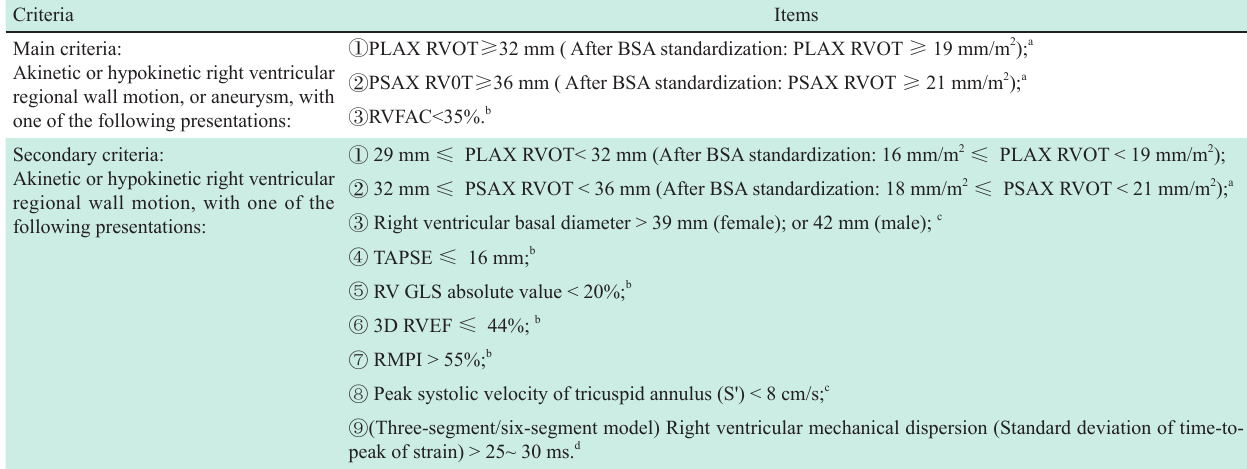
Table 4 Recommendation of diagnostic criteria